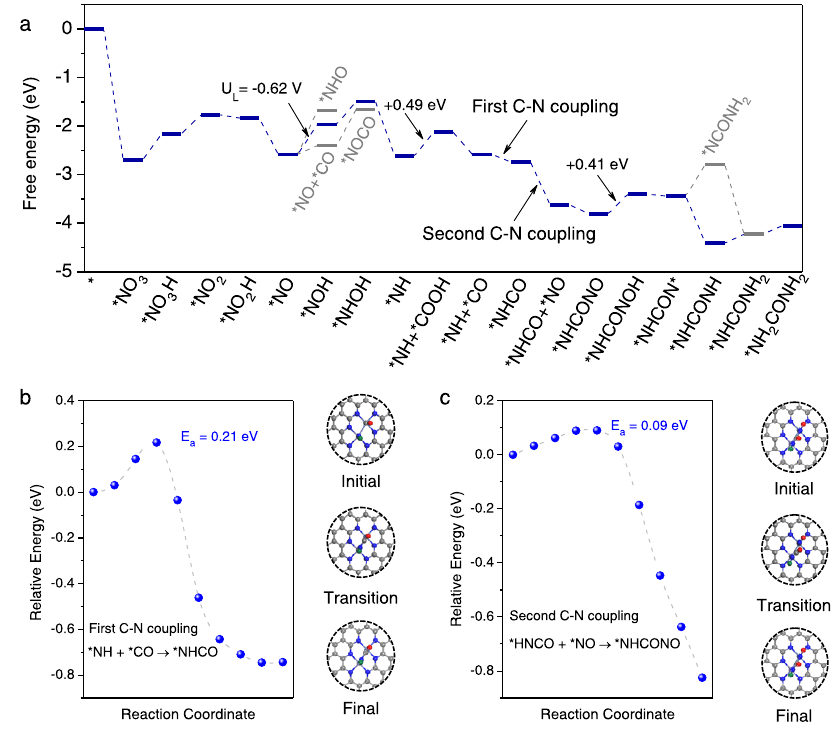
Fig. 4 | Thermodynamic and kinetic calculation results for urea synthesis. a Free energy diagram of urea production. b The reaction pathway of fi rst C – N coupling for *NHCO formation and c second C – N coupling for *NHCONO